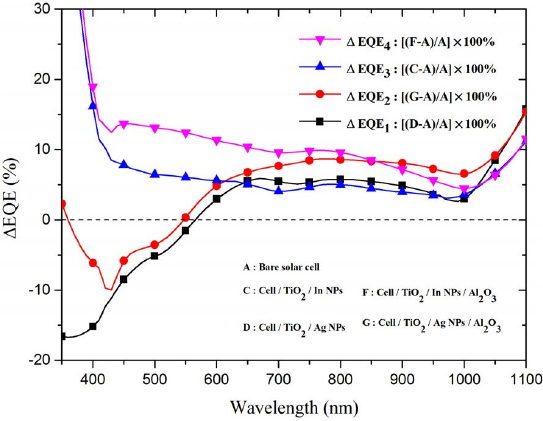
Figure 7. EQE response and optical reflectance of bare textured c-Si solar cell, cell with TiO 2 spacer layer, cell with Ag-NPs on TiO 2 spacer layer, and cell with Ag-NPs embedded in TiO 2 /Al 2 O 3 .